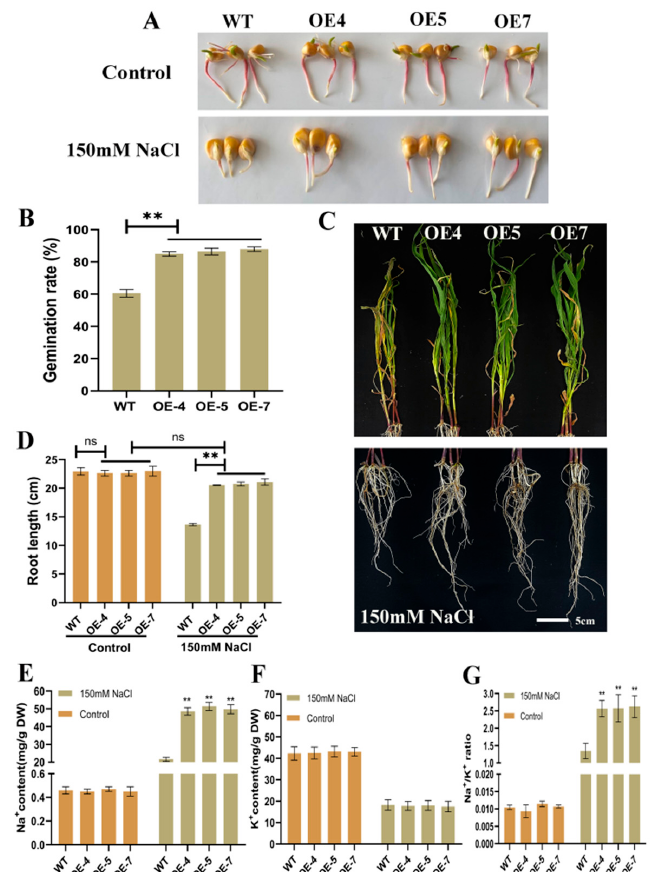
Figure 4. Salt tolerance of ZmSRG7 gene. ( A , B ) germination of WT and OE under salt stress. ( C , D ) root length and leaf phenotype under salt stress. ( E – G ) Na + , K + content and Na + : K + ratio under salt stress. Values are mean ± SD of three biological replicates. Bars with different letters are significantly different at p < 0.05 according to Duncan’s multiple range tests. Non-significance (ns), p < 0.05 (**). 2.5. Overexpression of ZmSRG7 in Transgenic Maize Can Improve the Antioxidant Capacity of Maize Next, 3,3’-diaminobenzidine (DAB) and Nitroblue tetrazolium (NBT) staining meth- ods were used to determine the antioxidant capacity of the overexpressed ZmSRG7 gene.